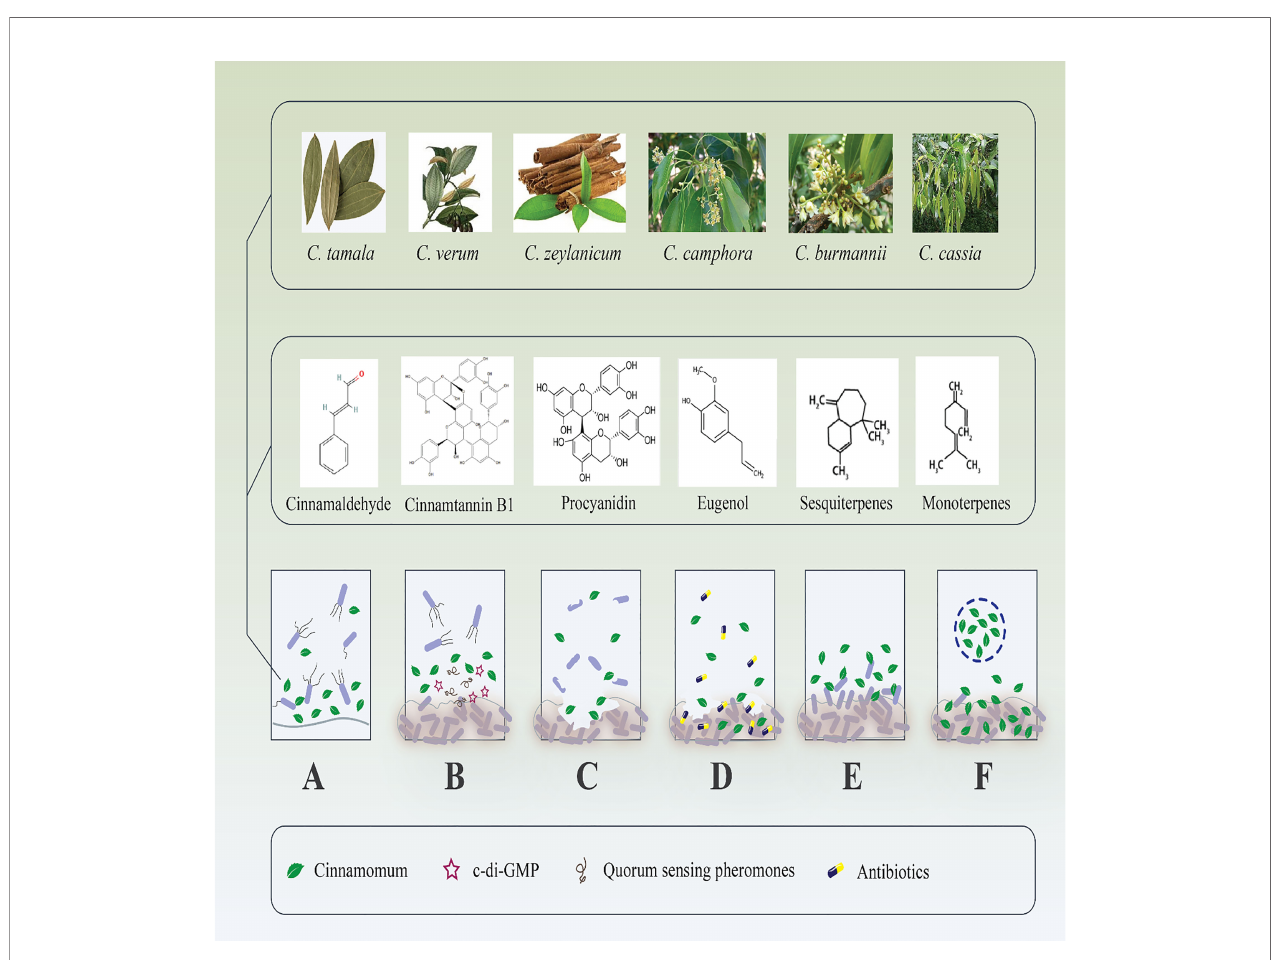
FIGURE 1 | Antibio fi lm effects of different species of Cinnamomum and their derivate components. (A) Inhibition of microbial adhesion to various surfaces. (B) Suppression of different bacterial cell signaling mediators that inhibit bio fi lm maturation. (C) Destruction of microbial established bio fi lm; consequently, (D) boost the antibiotic penetration to the dipper layer of the bio fi lm. (E) Handling of recalcitrant infections by repression of new bio fi lm formation. (F) Drug-delivery systems increase the effectiveness of Cinnamomum and their derivate components to destroy microbial bio fi